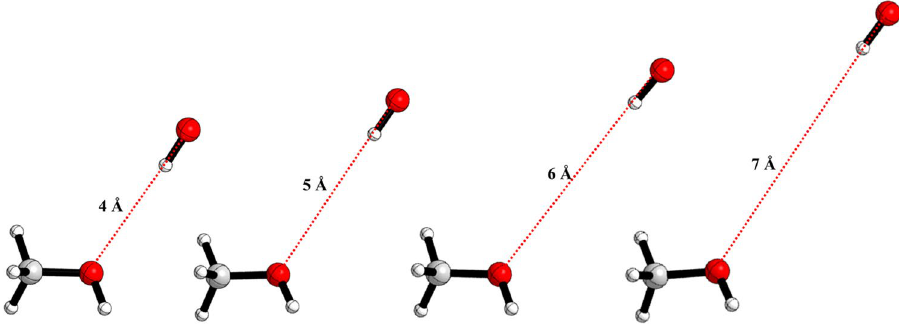
Figure 8. Dissociation of CH 3 OH···OH at several R O−O distances along the reaction of OH + CH 3 OH.